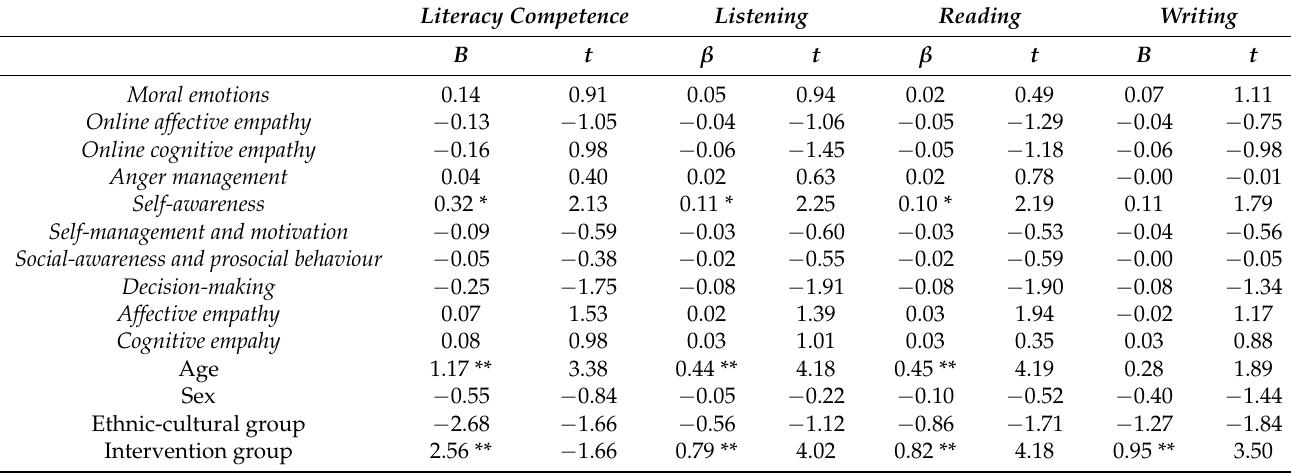
Table 4. Linear regression analyses with moral emotions , online empathy , anger management , socio-emotional competencies , empathy , and personal variables (age, gender, ethnic-cultural group membership, and intervention group) as longitudinal predictors of literacy competence ( n =